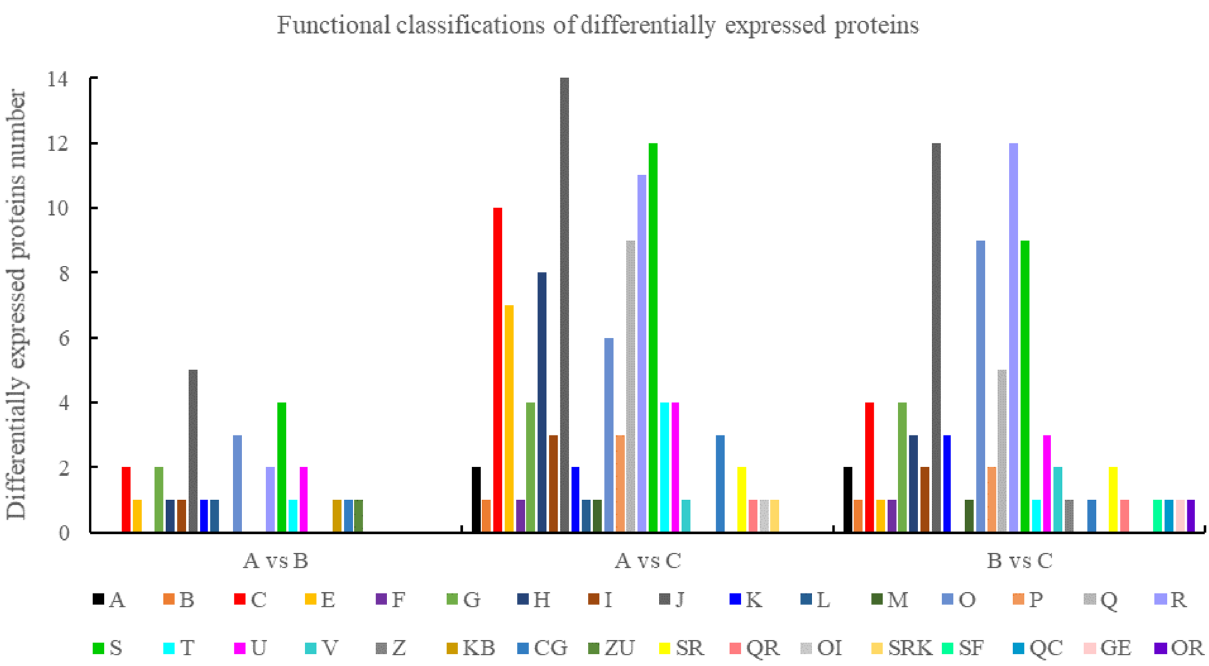
Figure 4. Functional classifications of differentially expressed proteins. Note : respectively. A: RNA processing and modification; B: Chromatin structure and dynamics; C: Energy production and conversion; E: Amino